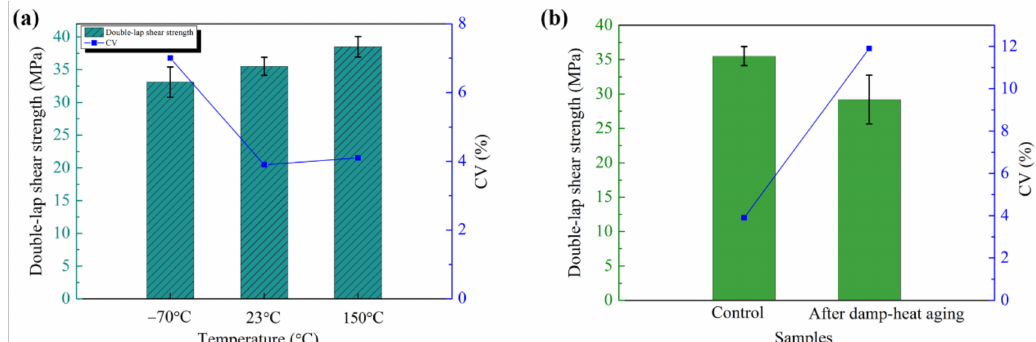
Figure 11. ( a ) Bonding performance of BMI-700 carbon fiber composite treated with J-412 BMI wet peel ply and ( b ) double- lap shear strength upon damp-heat aging (RH 95–100%, 71 ± 2 ◦ C, 1440